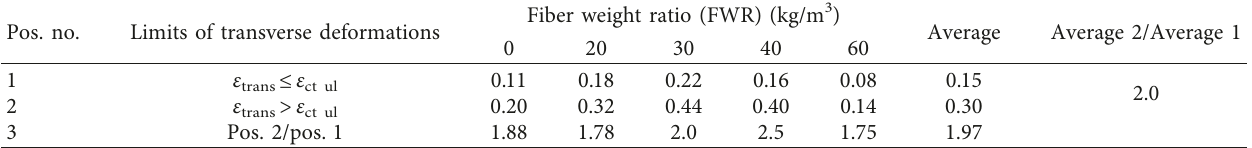
Table 4: Experimental values of Poisson’s coefficients for concrete class C 90 (pos. 1) and relation between transverse and longitudinal deformations (pos. 2).